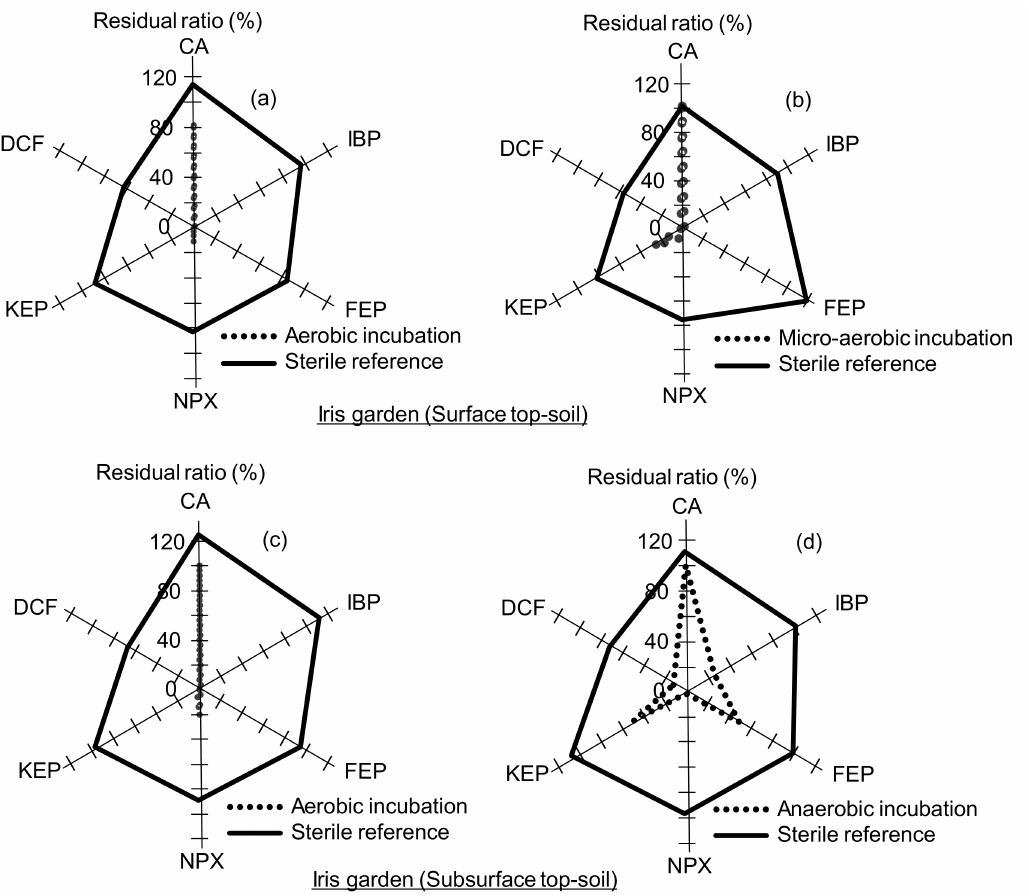
Figure 4. Residual ratios of the pharmaceuticals in slurry after 14 days of incubation under aerobic ( a , c ). micro-aerobic ( b ) and anaerobic ( d ) conditions. The soil was taken at the iris garden from surface top-soil layer ( a , b ) and subsurface soil layer ( c , d ).